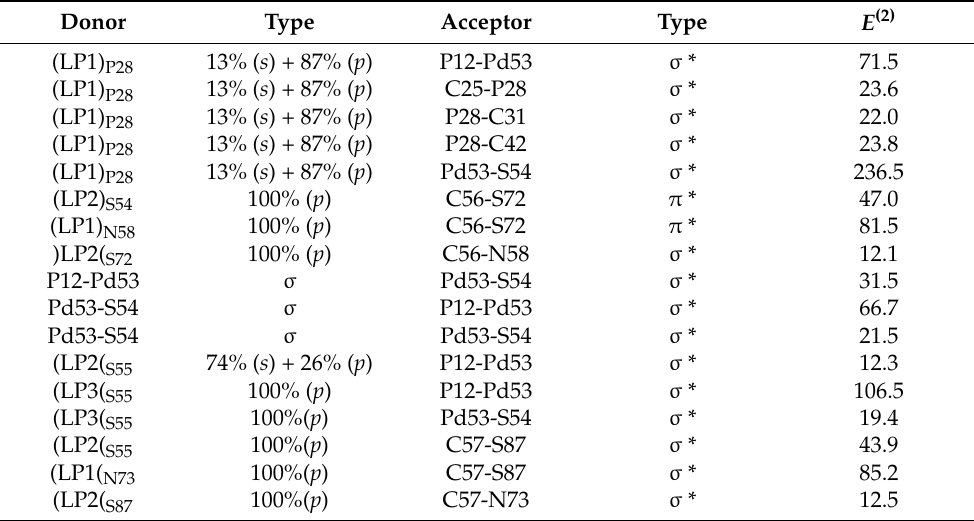
Table 5. Second order perturbation energies for charge transfers from donor to acceptor orbitals in Pd(1) .